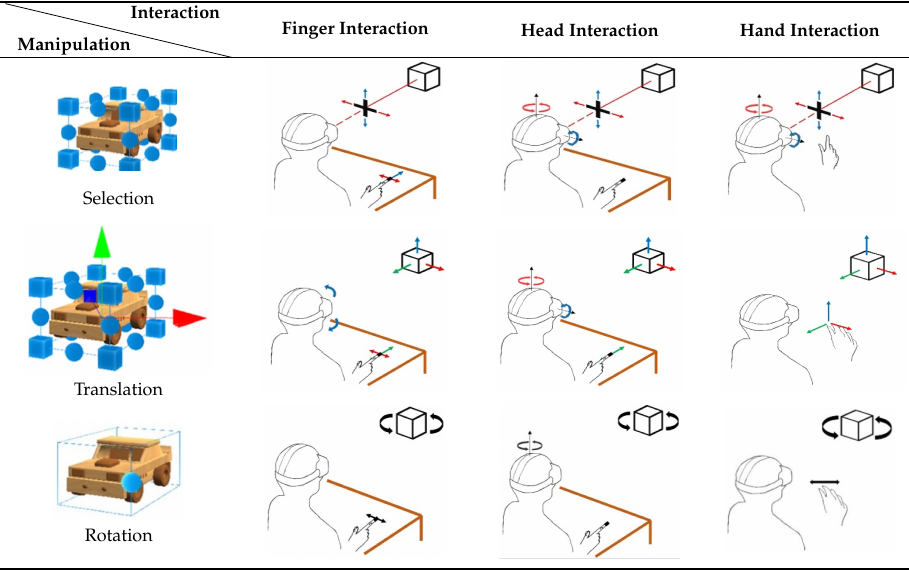
Figure 3. Conceptual illustration of manipulating the height of a virtual object with head rotation. Table 1. Each interaction method to manipulate a virtual